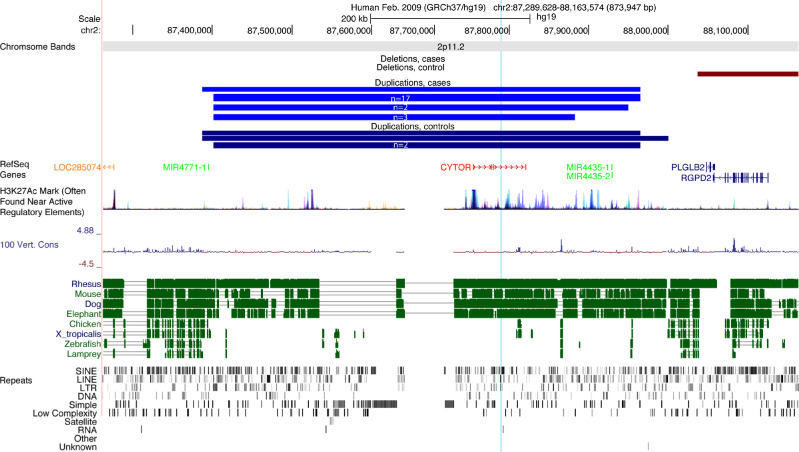
Chromosome 2 duplication significantly enriched in esotropia cases. UCSC genome browser plot showing the region of duplication on 2p11.2 (2:87428677-87965359). Duplications across this region were present in 23 cases (light blue, n indicates number with each set of breakpoints) and four controls (dark blue). A nearby deletion was present in one control (dark red). RefSeq genes are listed underneath. Protein coding genes are denoted in blue, lncRNA genes in red, micro RNAs in green, and noncoding RNAs in orange. H3K27Ac mark indicates several putative regulatory regions fall within the duplication. This area is not well conserved over 100 vertebrates, but the genic and putative regulatory regions are well conserved in primates and other mammals. The blue vertical line indicates the position of the ddPCR probe used to confirm the duplication. The gap in the annotations indicates an unmappable area of the reference genome, usually because it is highly repetitive or of low complexity. At bottom are indicated repeats in the region identified by RepeatMasker: SINE, short interspersed nuclear elements; LINE, long interspersed nuclear elements; LTR, long terminal repeat elements; DNA, DNA repeat elements; SIMPLE, microsatellites, low complexity repeats, satellite repeats, RNA repeats, and other repeats.